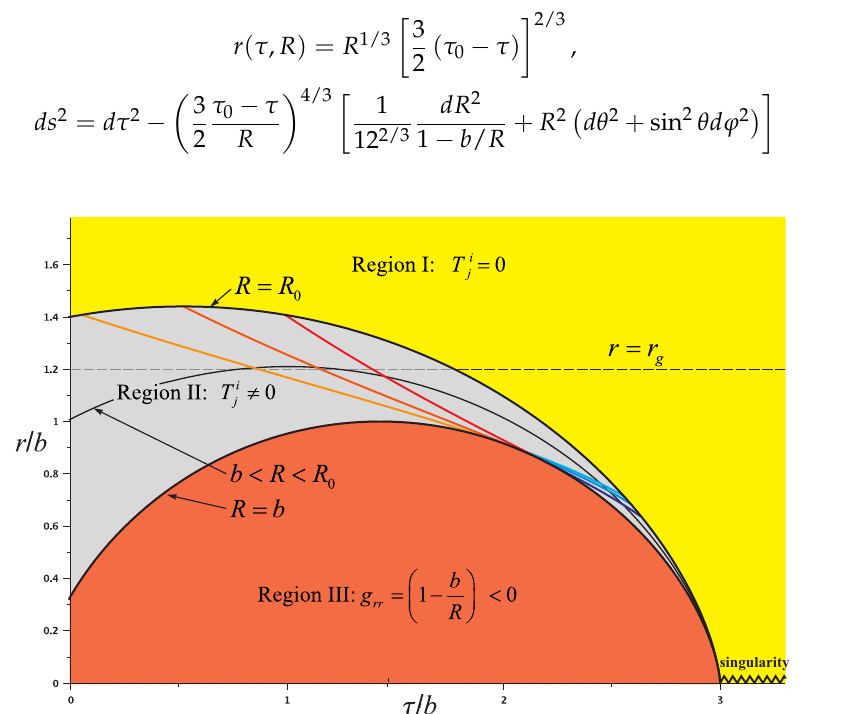
Figure 2. The figure shows the graphs of the function r ( R , τ ) / b depending on τ / b for different values of R : R = b , R = 1.1 b and R = R 0 , R 0 = 1.2 b . Red-blue lines are the null radial geodesics. (See the text for more details.)